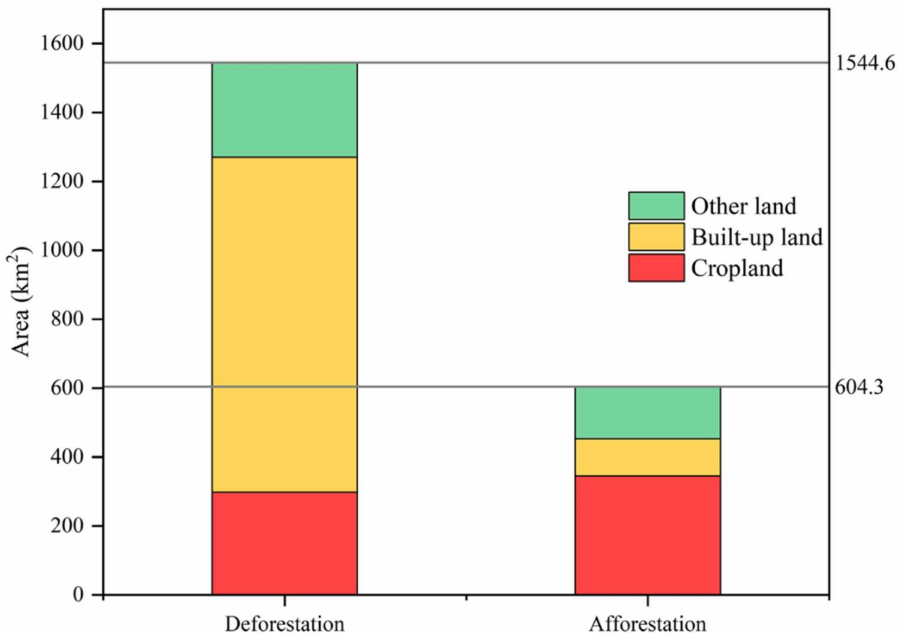
Figure 2. Conversion of forest land in the PRD urban agglomeration for 2000–2018.